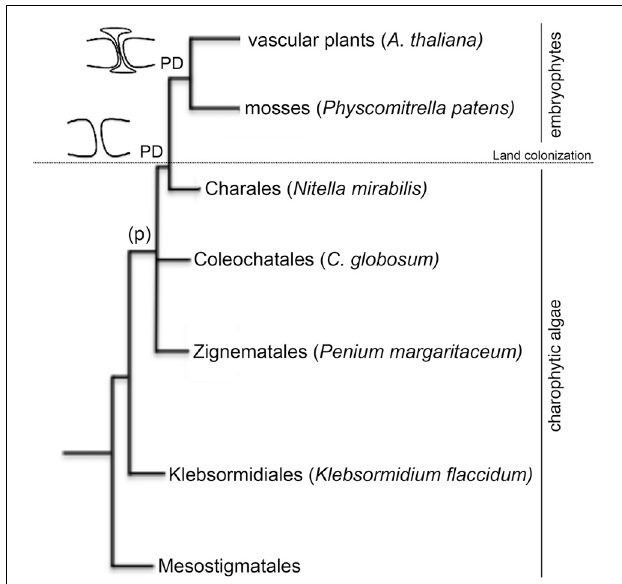
FIGURE 1 | Phylogenetic relationships of the species used in this study. The cladogram is based on the current view of land plant evolution (Qiu, 2008). Members of the order Mesostigmatales, Klebsormidiales, Zygnematales, Coleochatales, and Charales form the charophytic green algae lineage (land plant ancestors). Representatives from these orders selected for this study are named in the figure. Embryophytes (such as the moss Physcomitrella patents and the vascular plant Arabidopsis thaliana ) evolved from charophytic algae during land colonization. Phragmoplast (p) were found in organisms belonging to the Coleochatales and the Charales. Plasmodesmata (PD) appeared in all